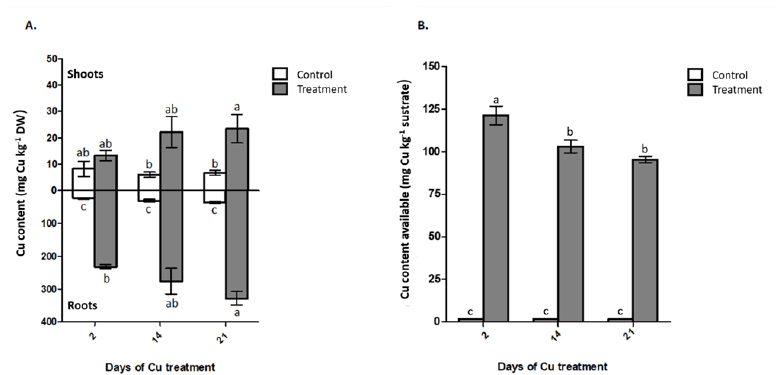
Figure 2. Copper concentrations. ( A ) Cu accumulation in shoots and roots of Imperata cylindrical ; ( B ) Cu content available in substrate. Where, control (without Cu applied) and treatment (300 mg Cu kg −1 substrate. Different lowercase letters indicate statistic difference according Tukey’s multiple range test ( p < 0.05). Data are expressed as mean ± SE, n = 4.